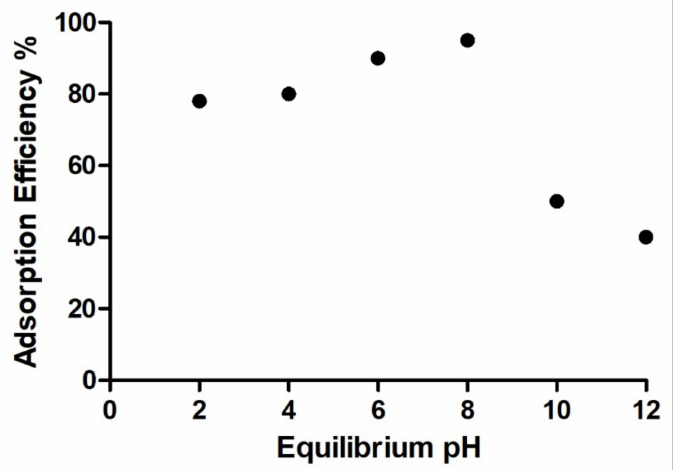
Figure 13. Adsorption efficiency % of MB a different pH (MB concentration = 200 mg/L, nanocom- posite content = 20 mg/20 mL, T = 25 ◦ C and 60